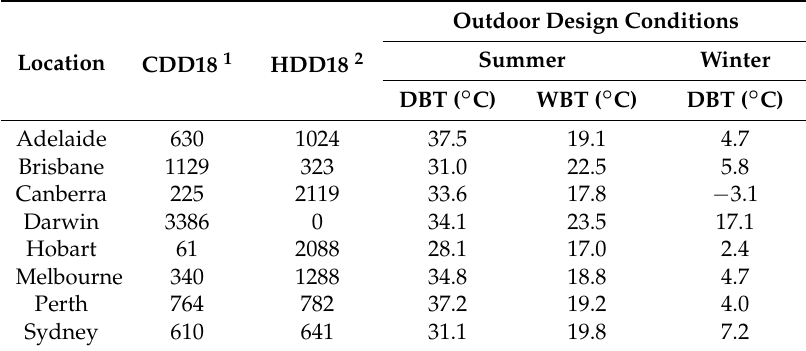
Table 1. Climatic indicators for Australian capital cities.